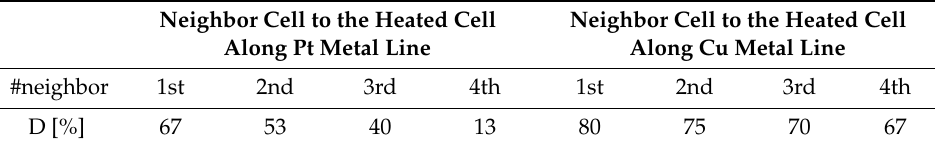
Table 1. Degradation D of the neighbor cells of the heated device. Neighbor Cell to the Heated Cell Along Pt Metal